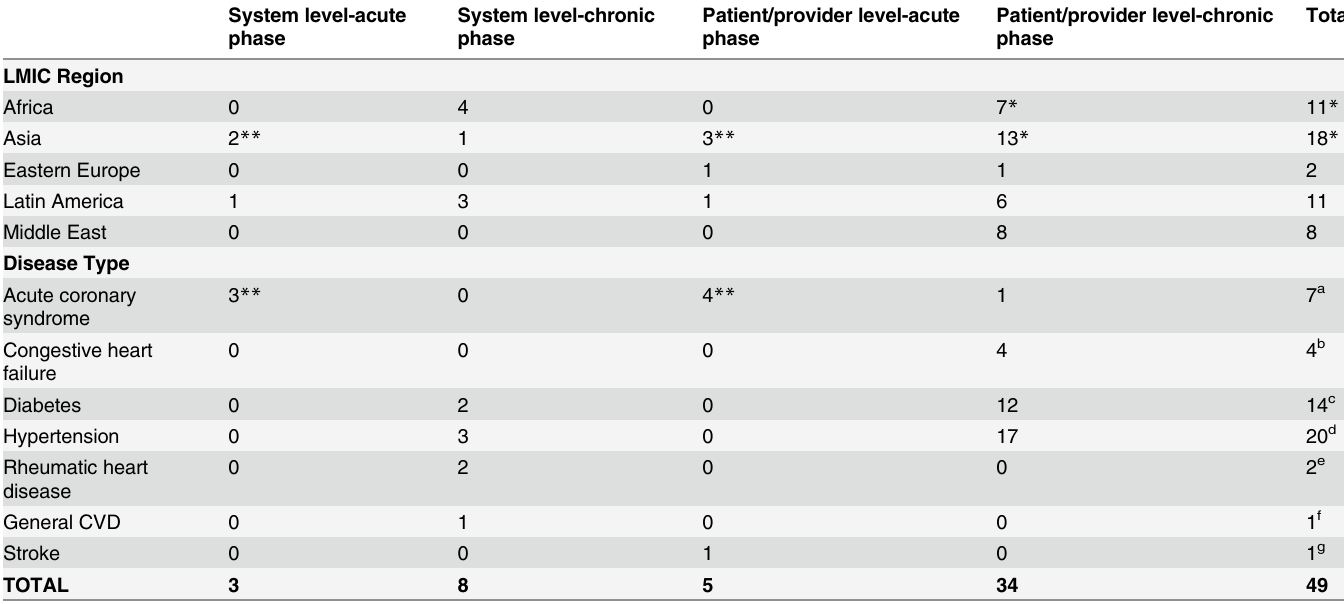
Table 1. Study Characteristics (n =